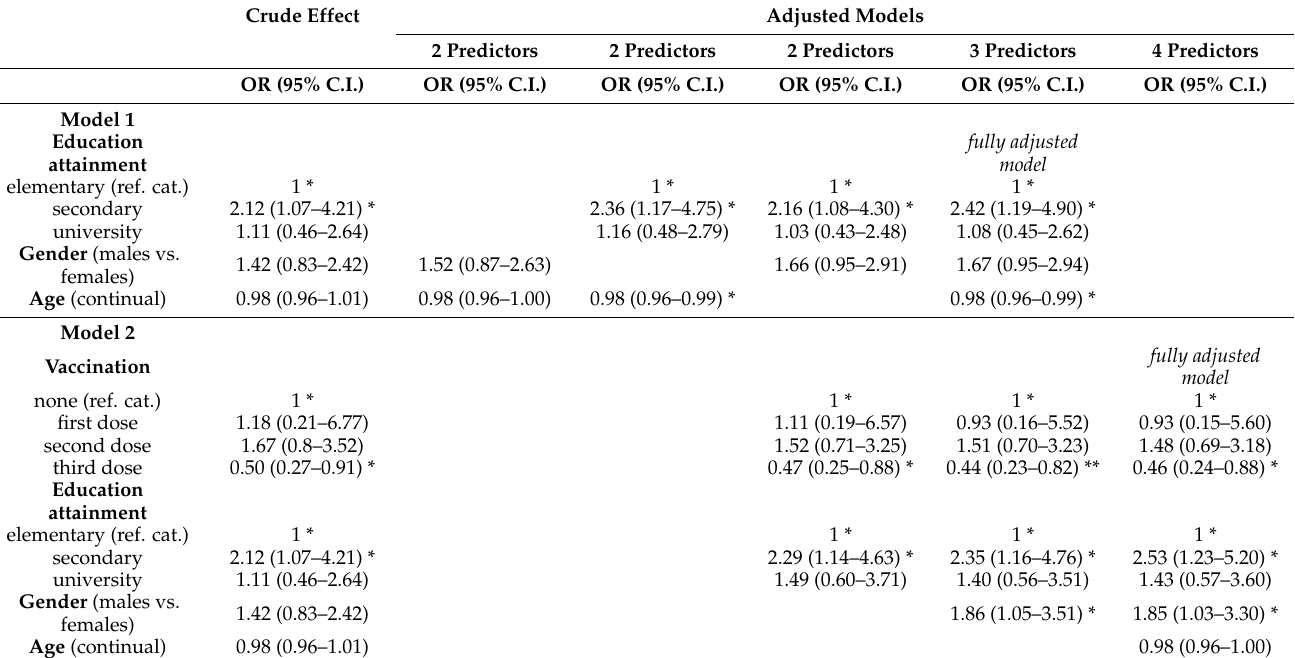
Table 6. Logistic regression models testing the crude and adjusted effects of three sociodemographic variables on contracting COVID-19 (Model 1) and testing the crude and adjusted effects of vaccination status with the sociodemographic variables on contracting COVID-19 (Model